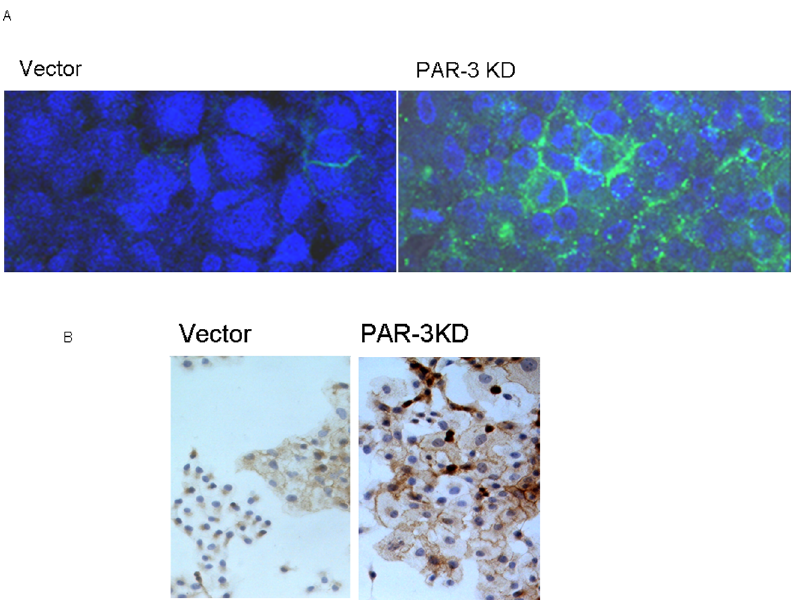
Figure 6. A- CHD1 and beta-catenin expression in Vector-control and PAR-3 KD cells. A- CHD1 immunofluorescent staining of Vector- control and PAR-3 KD cells Vector-control and PAR-3 KD cultures were stained for e-cadherin immunofluorescence and photographed using 25 6 objective as described in Methods. Blue- DAPI nuclear counterstain. B- Beta-catenin immunocytochemical staining. Vector-control or PAR-3 KD cultures were processed and stained for beta-catenin as described in Methods. Photomicrographs were acquired using 6 4 objective.